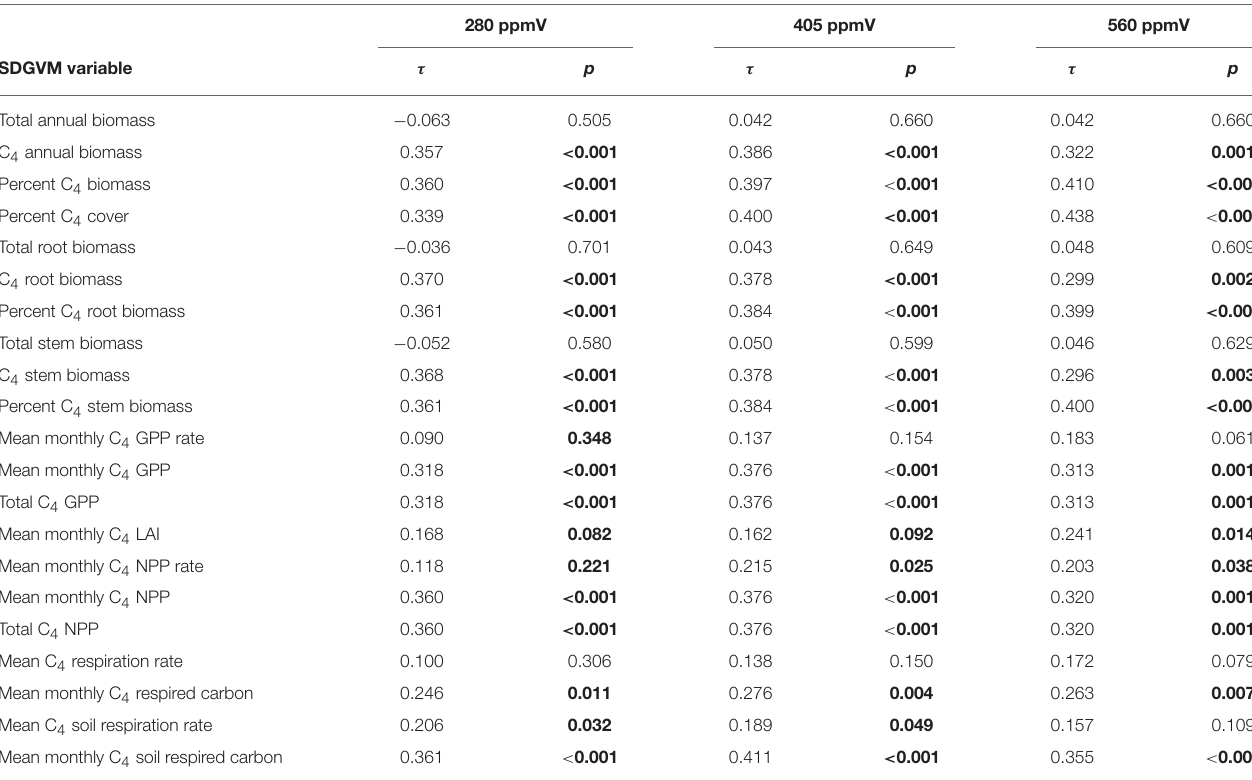
TABLE 4 | Kendall’s rank correlation coefficients ( τ ) and p -values for comparisons of estimates of mean percent C 4 biomass from δ 13 C-values of Pliocene biominerals with results of three cases of the